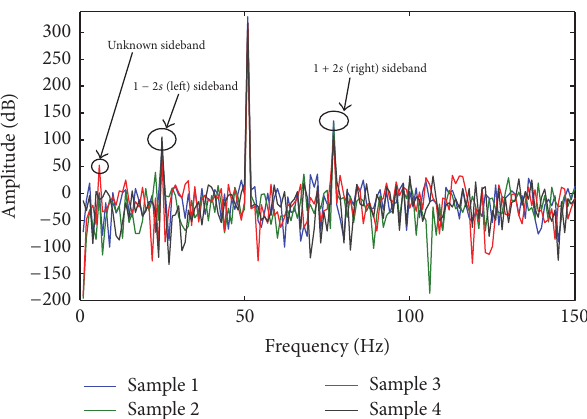
Figure 3: Measured current spectrum at full load with two broken rotor bars showing (1 ± 2𝑠)𝑓 𝑠 sidebands.